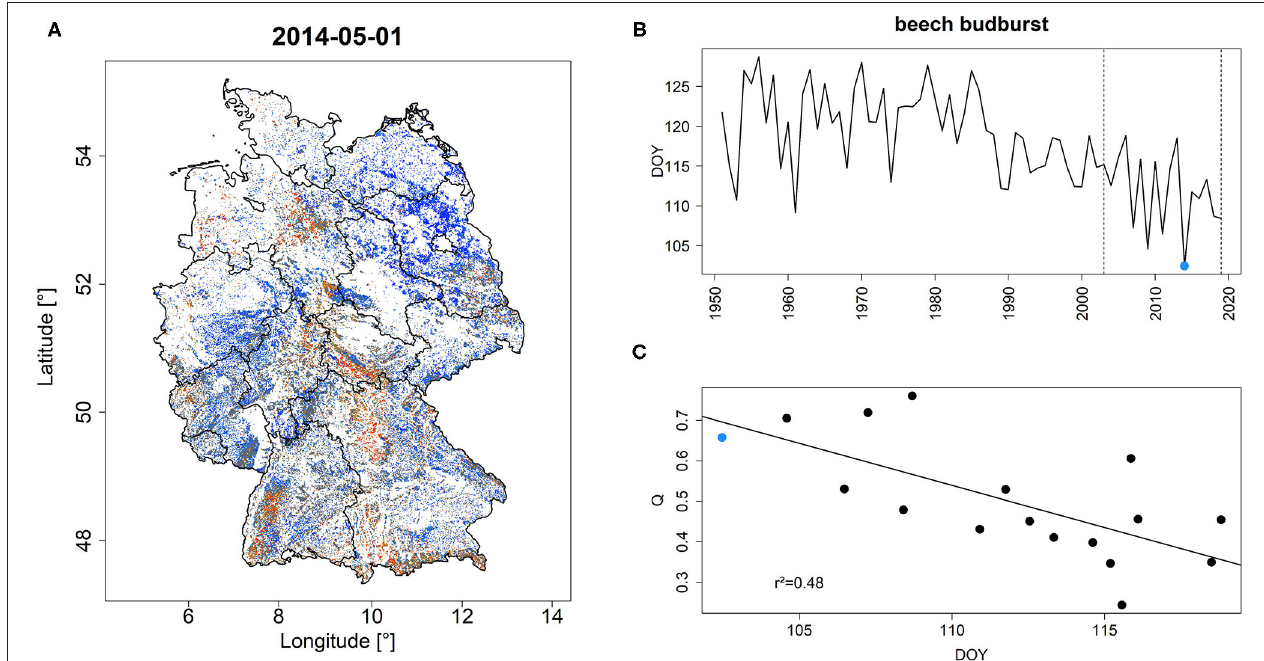
FIGURE 2 | Q -values in Germany for May 1, 2014 (A) which represents the year with the earliest bud-burst of beech across Germany for the period 1950–2020 (B) . Q features a significant negative relationship with the average DOY of beech budburst (C) . Vertical dashed lines in (B) refer to the common overlap period of beech phenology and monitoring period. The blue dot indicates the year 2014 which is depicted in (A) . r ² in (C) refers to the explained variance of the depicted regression line. A similar figure but for PDM is shown in Supplementary Figure 3